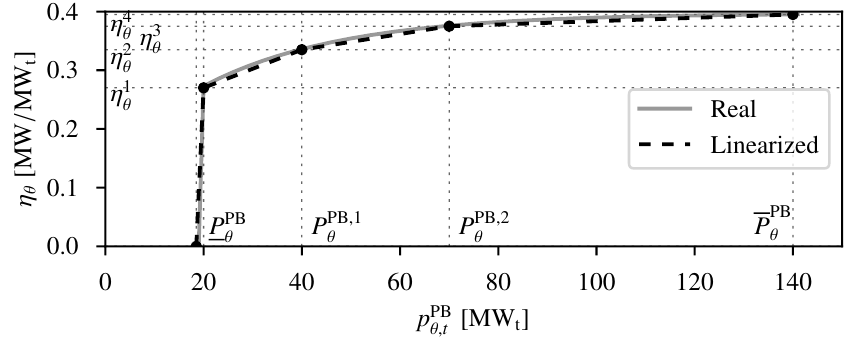
Figure 2. Power block conversion